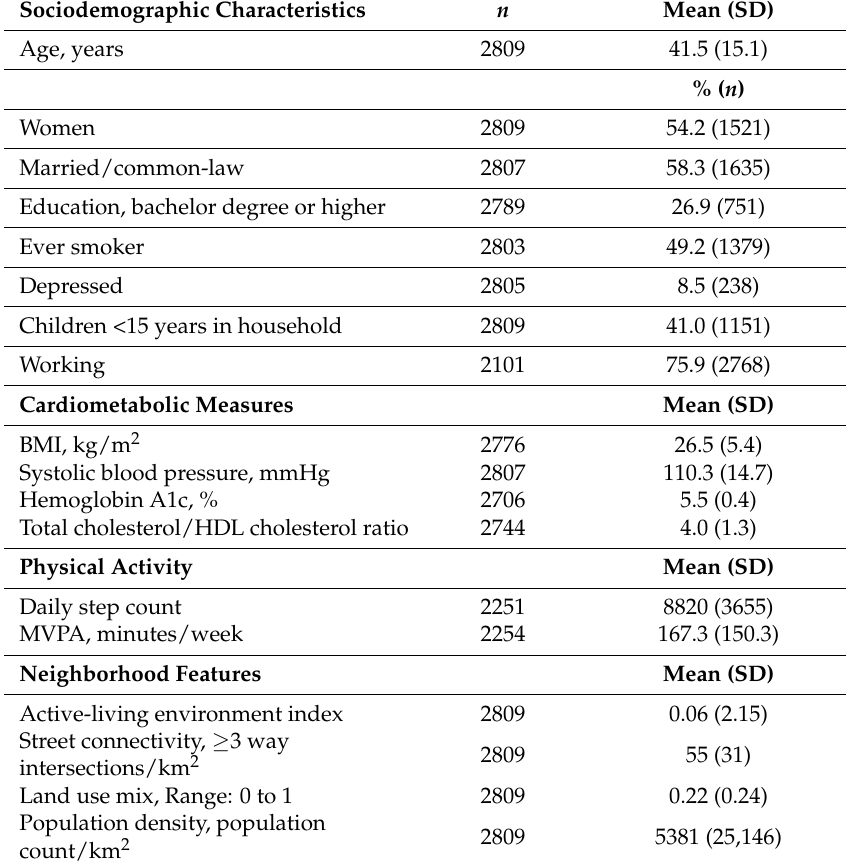
Table 1. Characteristics of the study population. Participants from the Canadian Health Measures Survey (2007–2009). MVPA, moderate-to-vigorous intensity physical